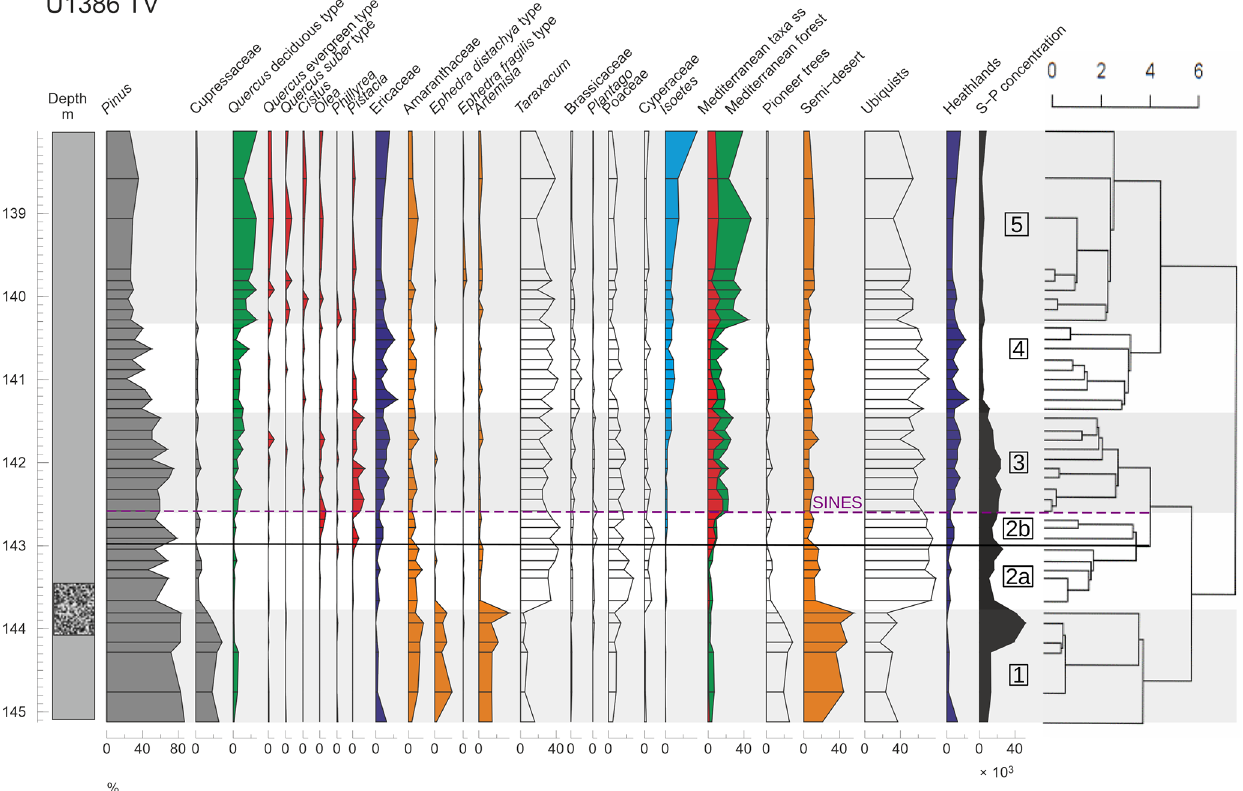
Figure 2. Pollen percentage diagram of selected morphotypes and ecological groups (described in Table 1) at site U1386 versus depth (cmcd). Lithology (full grey: muddy clay; dotted black: clayey silt; from Moal-Darrigade et al., 2022a) and sporo-pollen (S-P) concentrations (grainscm 3 − 3 ) are displayed on both sides of the diagram (left and right respectively). Alternating grey and white shading with corresponding numbers indicates pollen zones, and the black line sets the limit between sub-zones U1386-2a and U1386-2b. The dendrogram showing the results from the hierarchical clustering analysis is represented on the right. The purple dashed line indicates the onset of the SINES regional terrestrial interglacial. The same colours are used for the ecological groups and the main morphotype components thereof.